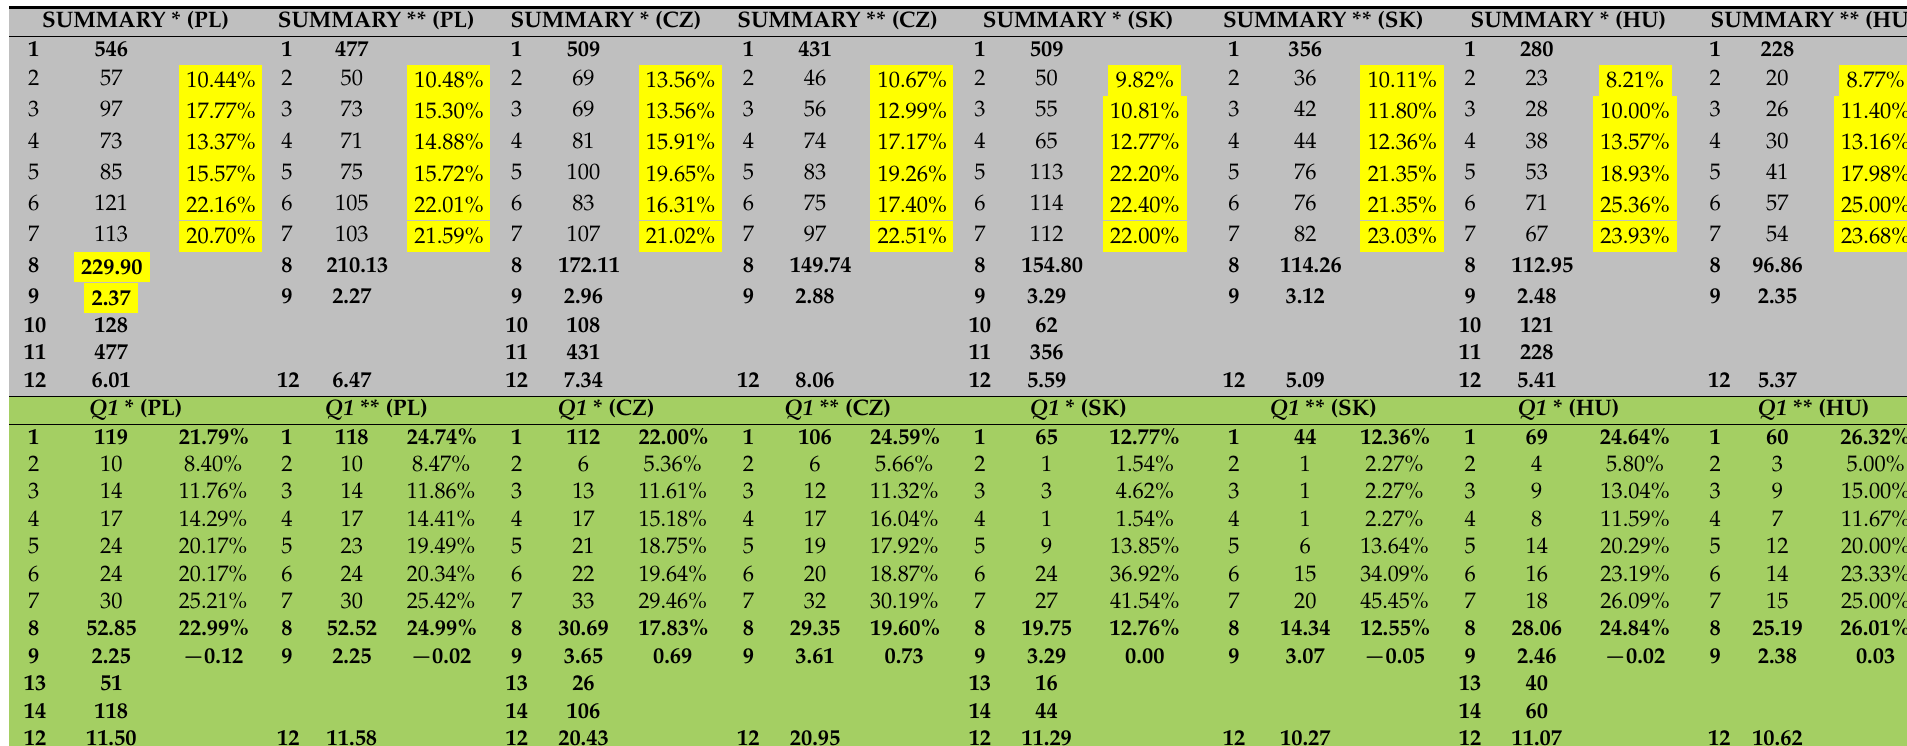
Table 3. Scientific metrics data determining the quality of publication performance of top 50 researchers in the Central European V4 countries (in the period of